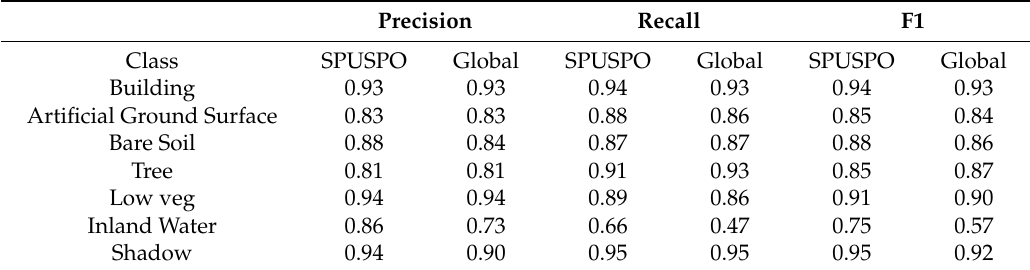
Table 2. Precision, Recall and F-score metrics for each LULC class with SPUSPO and global USPO, respectively.